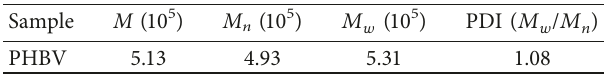
Table 2: Molar masses and mechanical properties of PHBV